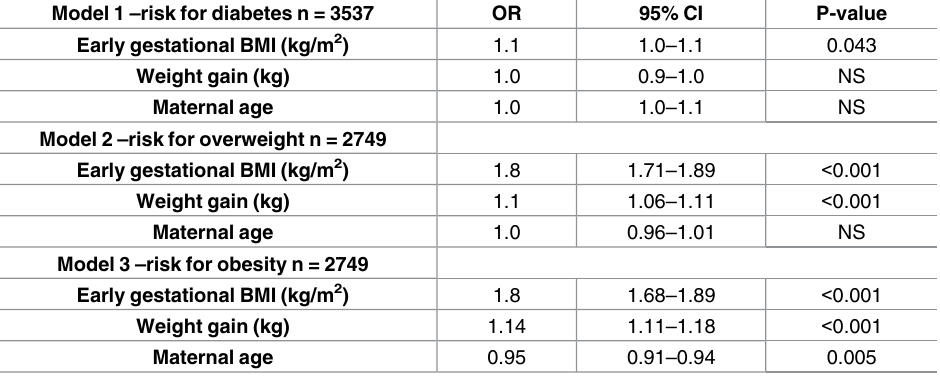
Table 4. Early gestational BMI and gestational weight gain as risk factors for diabetes, overweight and obesity in a multivariate